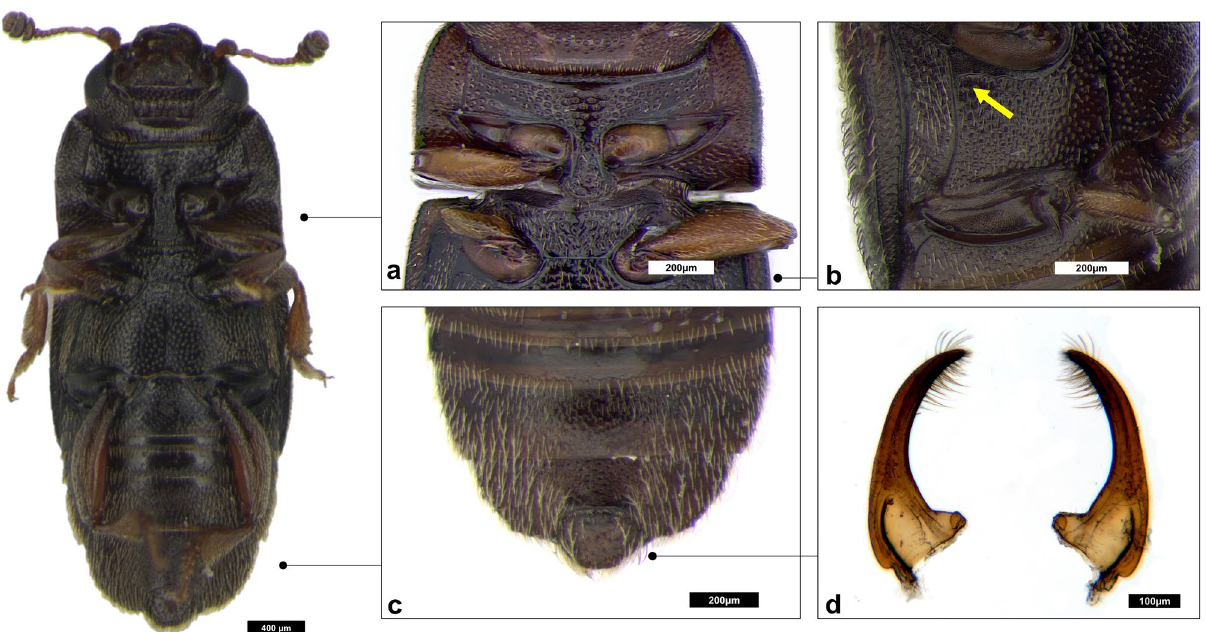
Figure 2. Ventral view of Carpophilus truncatus . Qualitative observation. a: absence of median longitudinal ridge on the mesosternum; b: shape of posterior rim of mesocoxal cavities and axillary space; c: setation on 5th ventrite and the supplementary segment of male and absence of depressions on 5th ventrite; d: Male genitalia, parameres (specimen